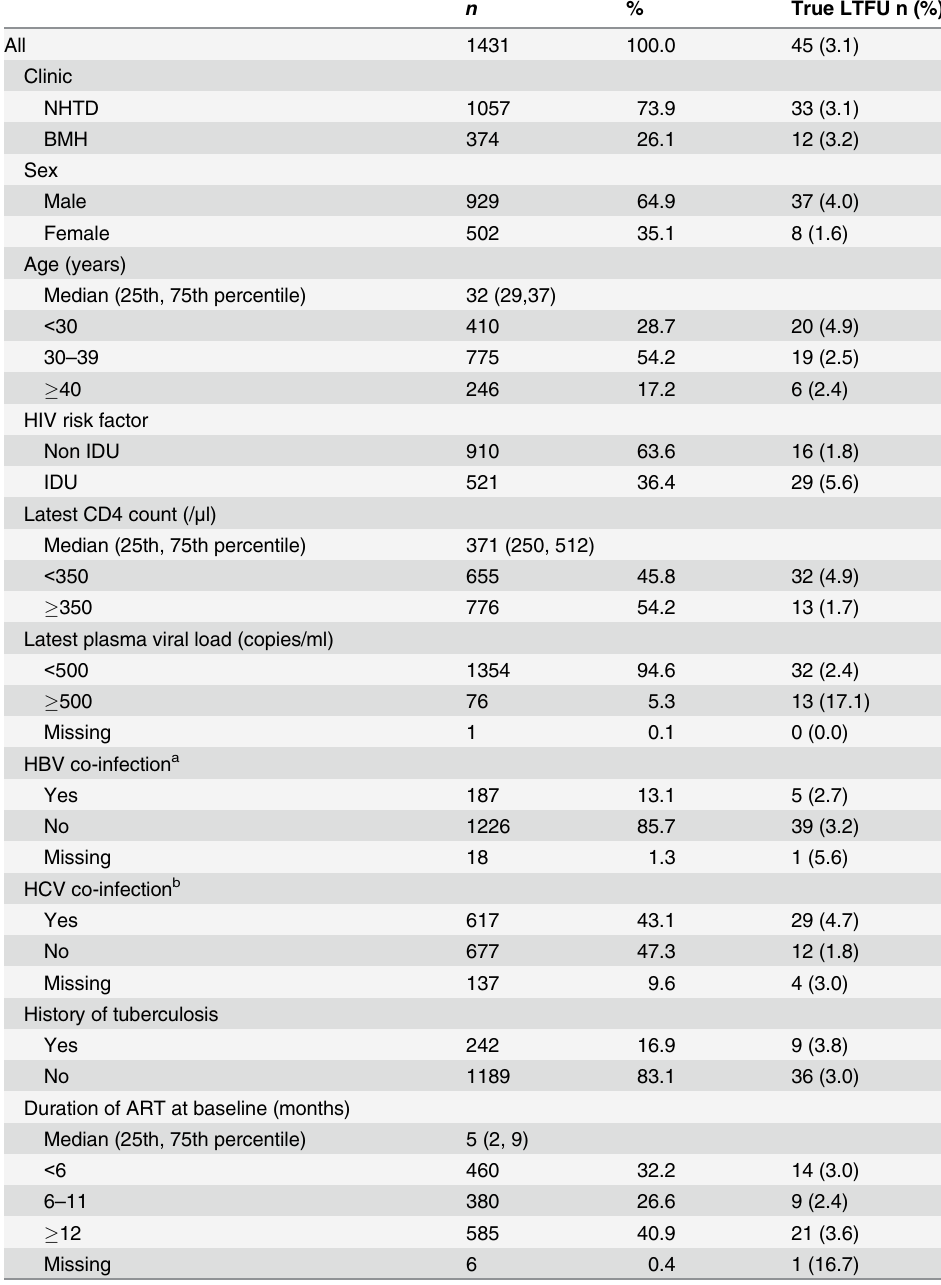
Table 1. Patient